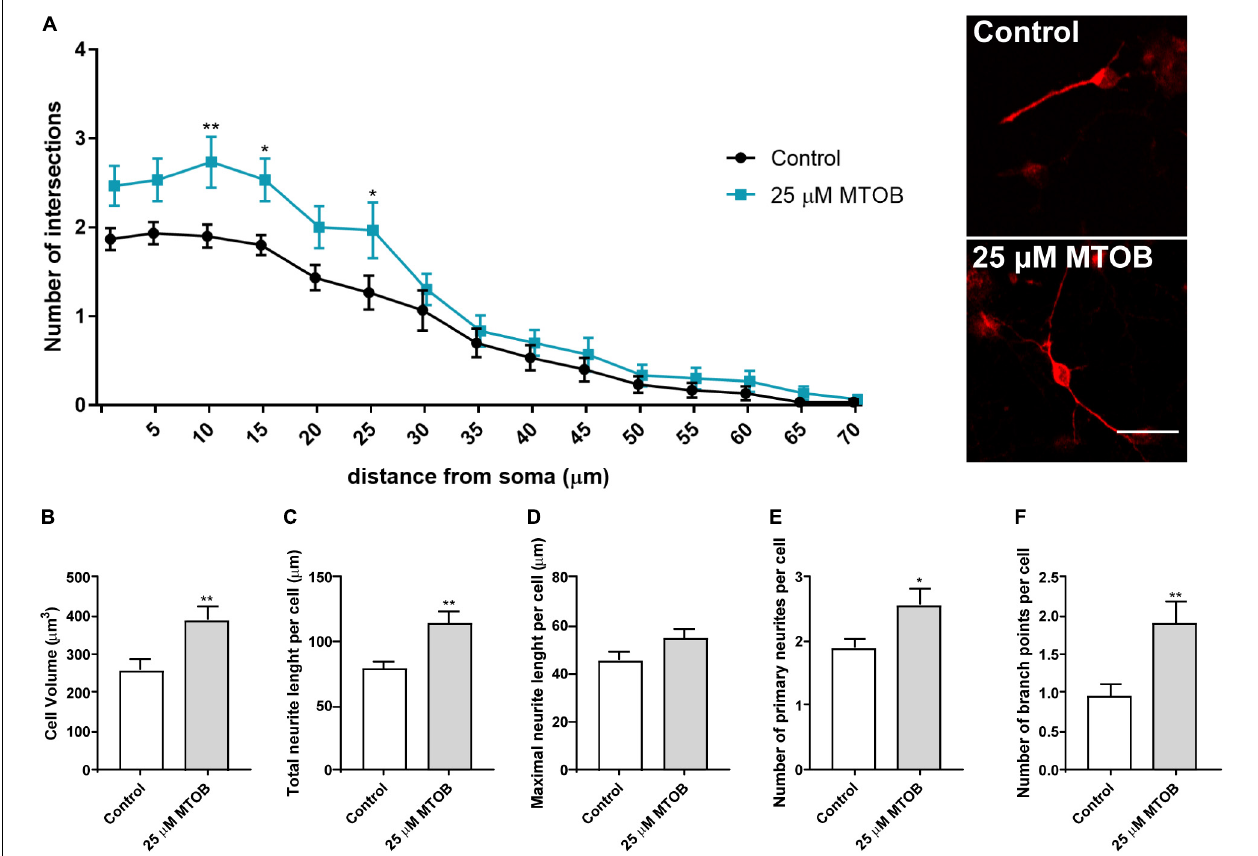
FIGURE 8 | CtBP modulation increases the dendritic structure and complexity of immature neurons. (A) Sholl analysis of DCX + cells revealed differences at several distances from the soma in the number of intersections of DCX + immature neurons, after the treatment with 25 µ M of MTOB for 7 days. n = 30 cells from three independent experiments. * p < 0.05 and ** p < 0.01 when compared with control, using two-way ANOVA, followed by the Sidak’s multiple comparison test. (B–F) Bar graphs depict (B) cell volume, (C) total length, (D) maximal length, (E) number of primary of neurites per cell, (F) and the number of ramifications of neurites per cell. Data are expressed as mean ± SEM. n = 30 cells. * p < 0.05 and ** p < 0.01 when compared with control, using unpaired Student’s t -test. Representative confocal images of DCX + cells are shown next to the graph of Sholl analysis. Scale bar: 20 µ